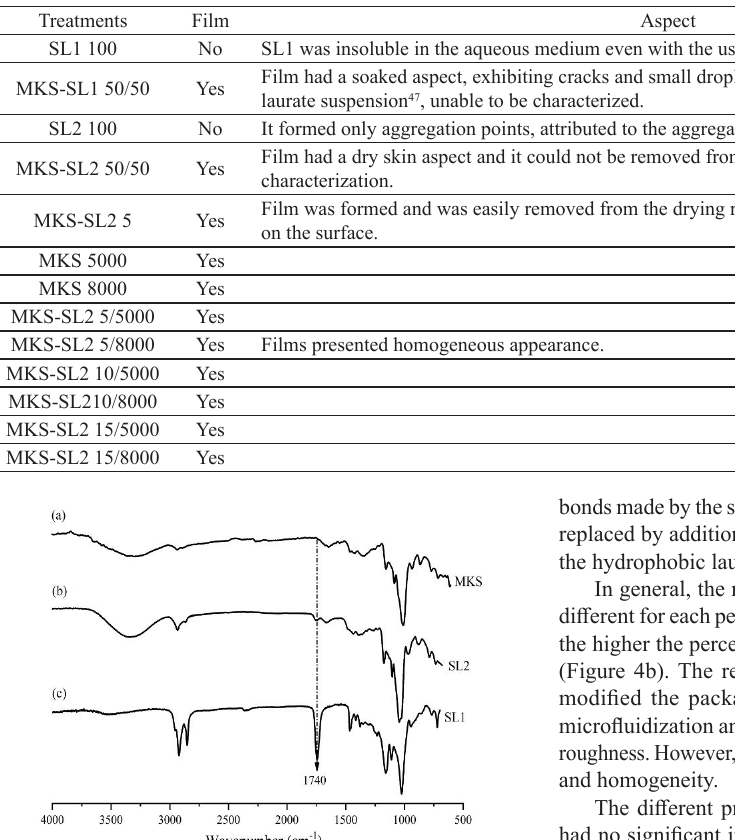
Table 3. Preliminary tests carried out to verify the formation of films with the obtained products (SL1 and SL2). Treatments